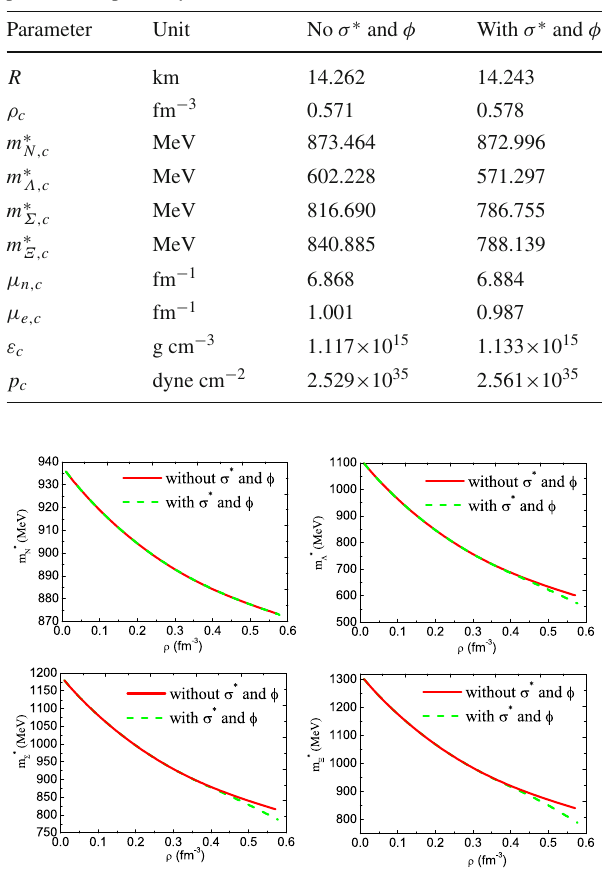
Table 1 The results of the calculation of the PNS PSR J0740+6620 in this work. The mass of PNS PSR J0740+6620 is M = 2.14 M (cid:2) . R and ρ c are the radius and the central baryon density of the PNS PSR J0740+6620, respectively. m ∗ , m ∗ Λ, , m ∗ Σ, and m ∗ Ξ, are the center c c c N , c effective masses of nucleon N and hyperons Λ , Σ and Ξ , respectively. μ μ n , c and e , c are the chemical potentials of neutron n and electron e, respectively. ε c and p c are the central energy density and the central pressure, respectively